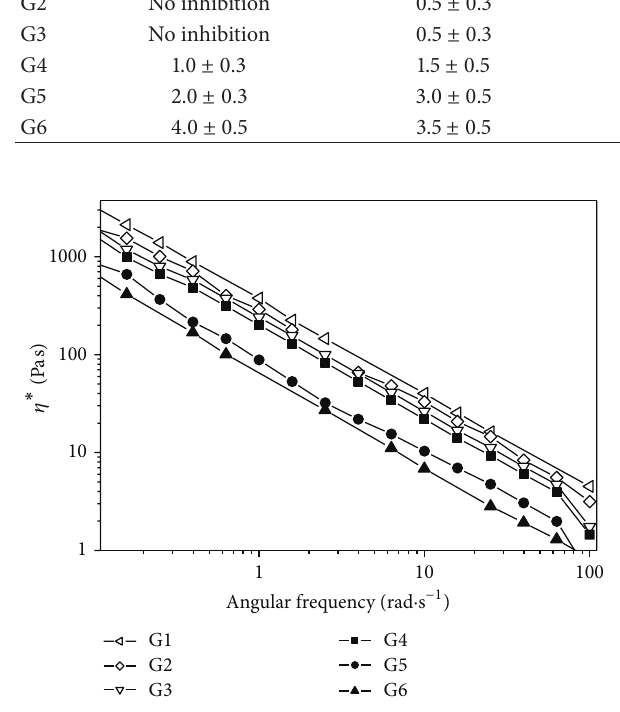
Figure 7: Complex viscosity versus angular frequency dependence of the hydrogel systems.